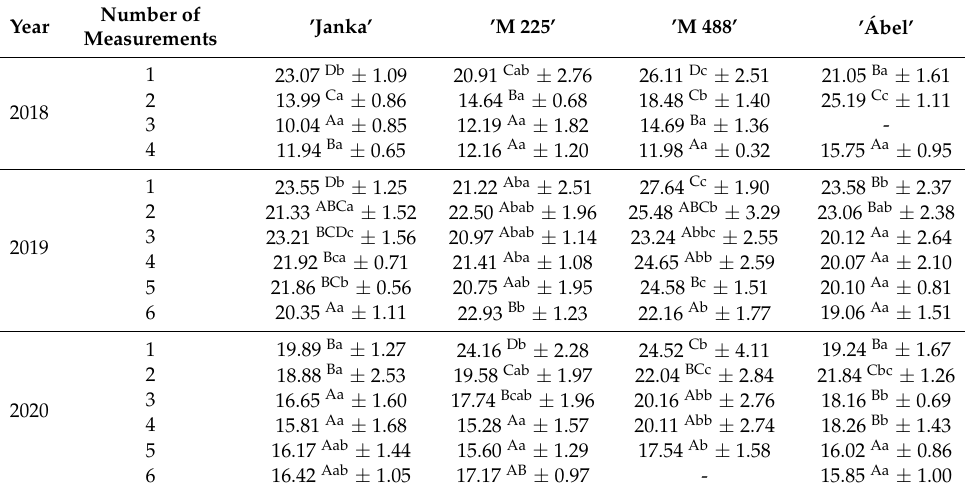
Table 4. Seed moisture content (%) value changes of four rice varieties (Szarvas, Hungary, 2018, 2019, 2020). The different lowercases mean significant differences among the varieties at level 0.05, and the different capital letters show significant differences within varieties among the measurement times at level 0.05.